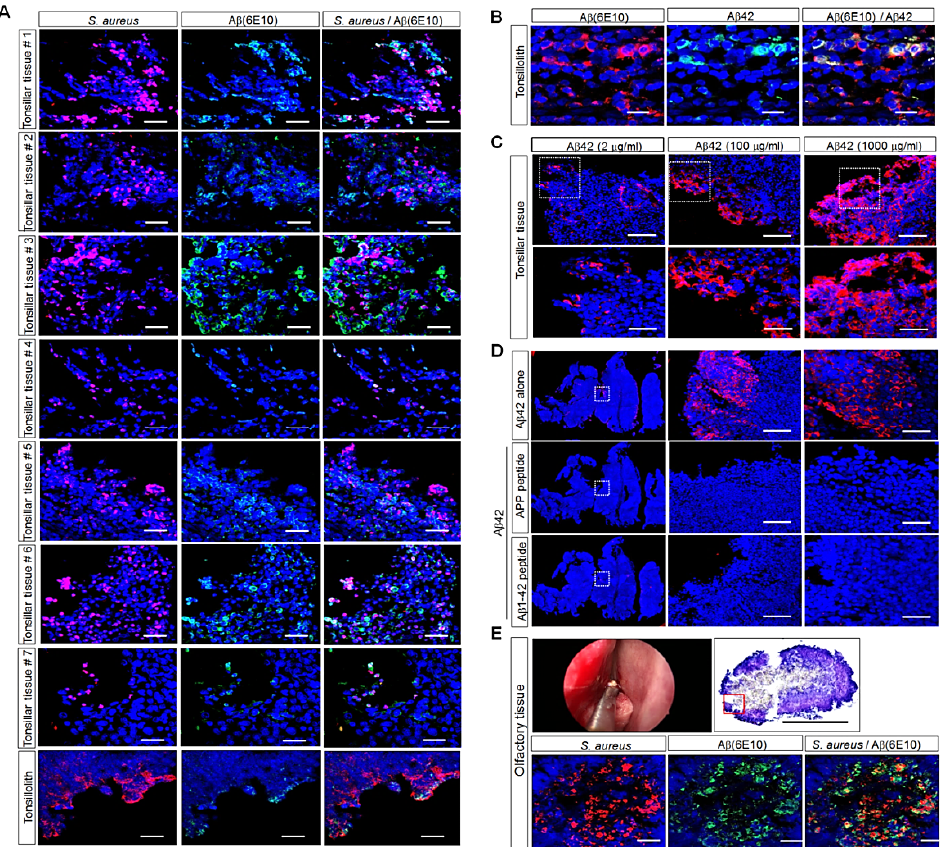
Figure 2. Histological analyses of human palatine-tonsil specimens or human olfactory mucosal epithelium subjected to immunohistostaining. ( A ) Confocal-microscopy images after the double staining of OCT-embedded human palatine-tonsil sections with antibodies against S. aureus (red) and A β -peptide-specific 6E10 (green) (tissue #1, 9 years old; tissue #2, 11 years old; tissue #3, 16 years old; tissue #4, 43 years old; tissue #5, 7 years old; tissue #6, 8 years old; tissue #7, 8 years old). Nuclei were labeled with DAPI (blue). Scale bar: 20 µm. All images are representative of two or three independent experiments. ( B ) Confocal-microscopy images after the double staining of OCT-embedded human palatine-tonsil sections with antibodies against 6E10 antibody (green) or the A β 42 antibody (red) to detect A β deposition. Scale bars: 20 µ m, 10 µ m. ( C ) Confocal-microscopy images after the staining of OCT-embedded human palatine-tonsil sections with three different concentrations of the anti-A β 42 antibody (red) in to detect A β deposition. Scale bars: 50 µ m, 20 µ m. ( D ) Confocal-microscopy images after the staining of OCT-embedded human palatine-tonsil sections with anti-A β 42 or neutralized antibodies (red) to detect A β deposition. Scale bars: 100 µ m, 50 µ m. ( E ) Confocal-microscopy images after the double staining of an OCT-embedded section similar to tonsilloliths found in the human olfactory mucosal epithelium with antibodies against S. aureus (red) and A β -peptide-specific 6E10 (green) (olfactory tissue, 80 years old). Nuclei were labeled with DAPI (blue). Scale bars: 100 µ m, 20 µ m. All images are representative of two or three independent